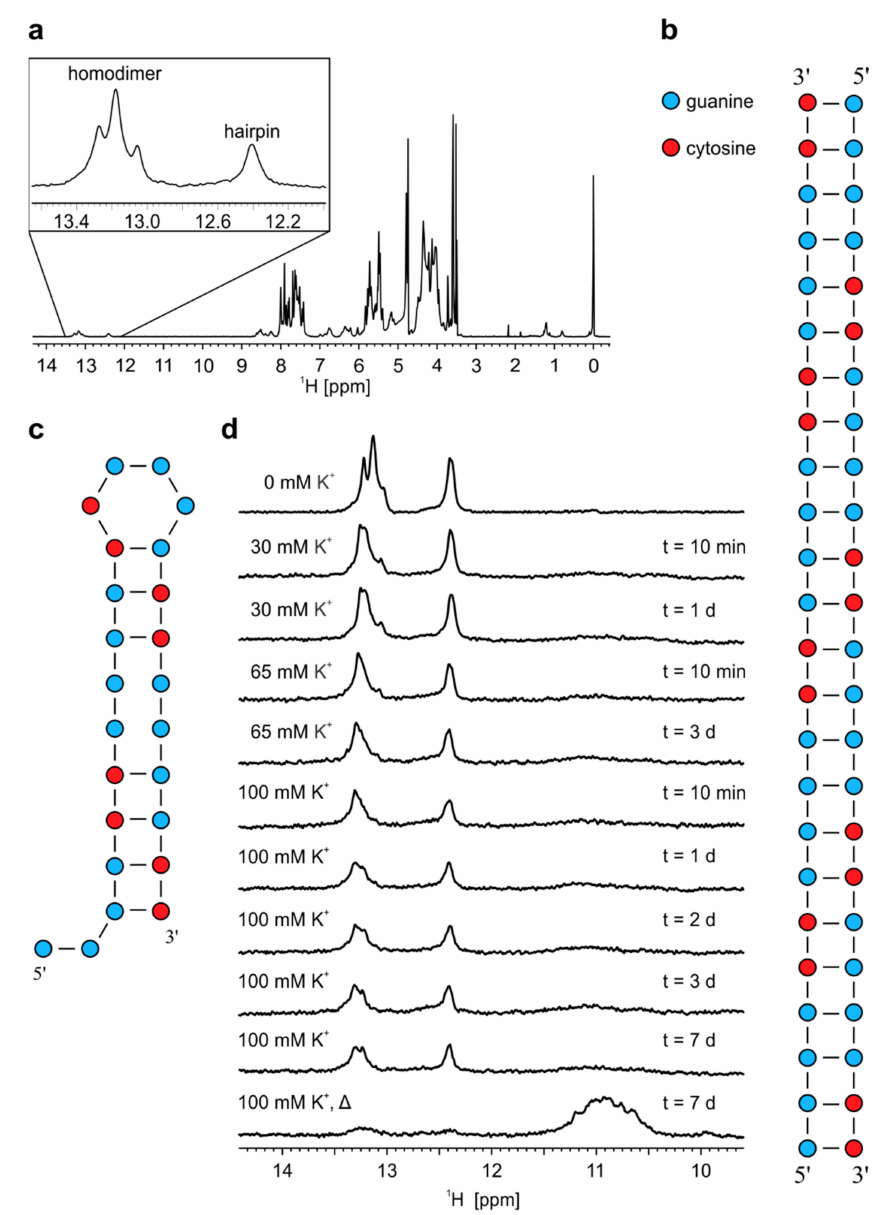
Figure 3. 1 H-NMR spectra and proposed models of structures adopted by r(G 4 C 2 ) 4 . ( a ) 1 H-NMR spectrum of r(G 4 C 2 ) 4 in 10% 2 H 2 O at pH 6.0, 25 ◦ C and 0.9 mM oligonucleotide concentration per strand. Schematic presentation of ( b ) homodimer and ( c ) hairpin adopted by r(G 4 C 2 ) 4 . ( d ) Imino regions of 1 H-NMR spectra of r(G 4 C 2 ) 4 in 10% 2 H 2 O at di ff erent concentrations of K + ions. KCl